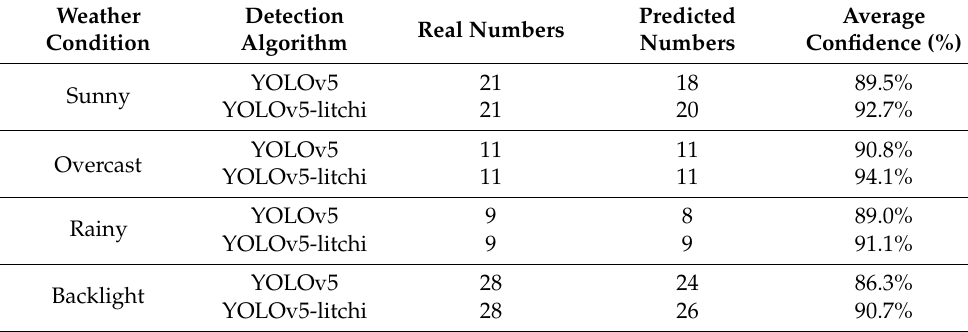
Table 4. The test results under different weather